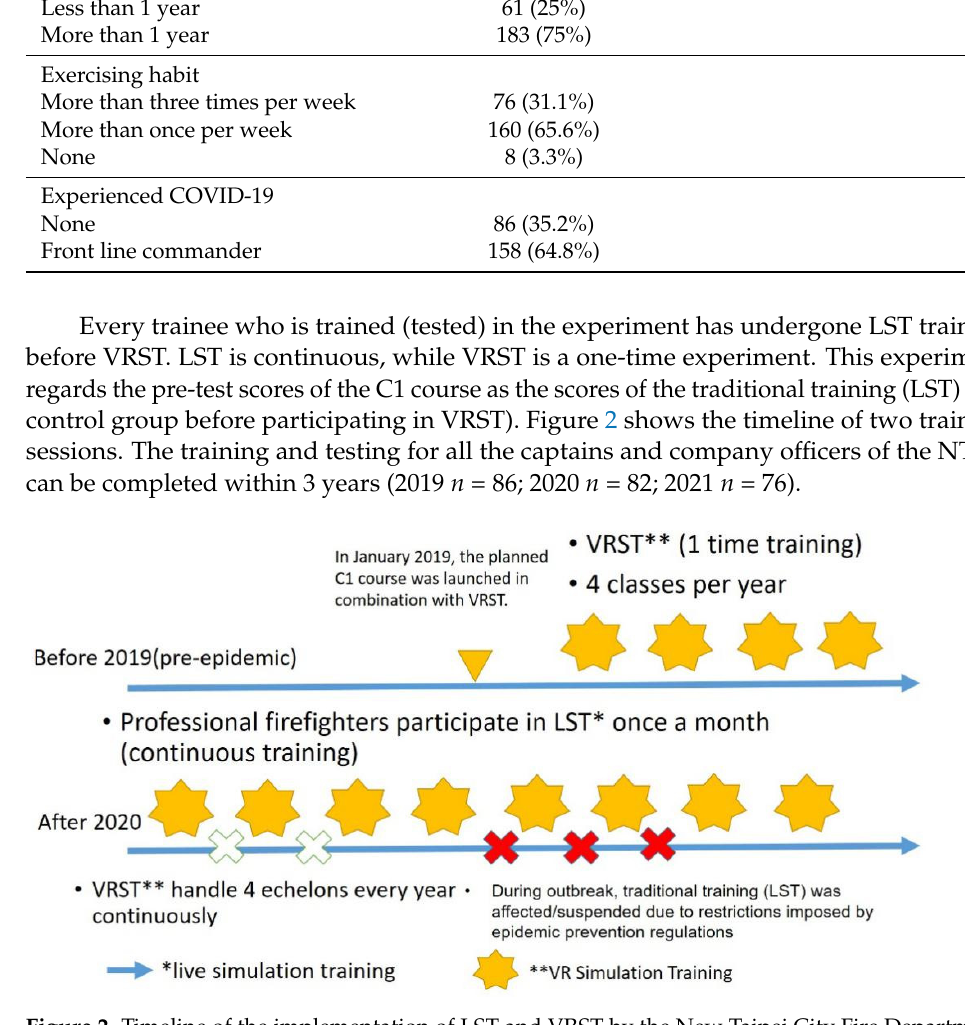
Figure 2. Timeline of the implementation of LST and VRST by the New Taipei City Fire